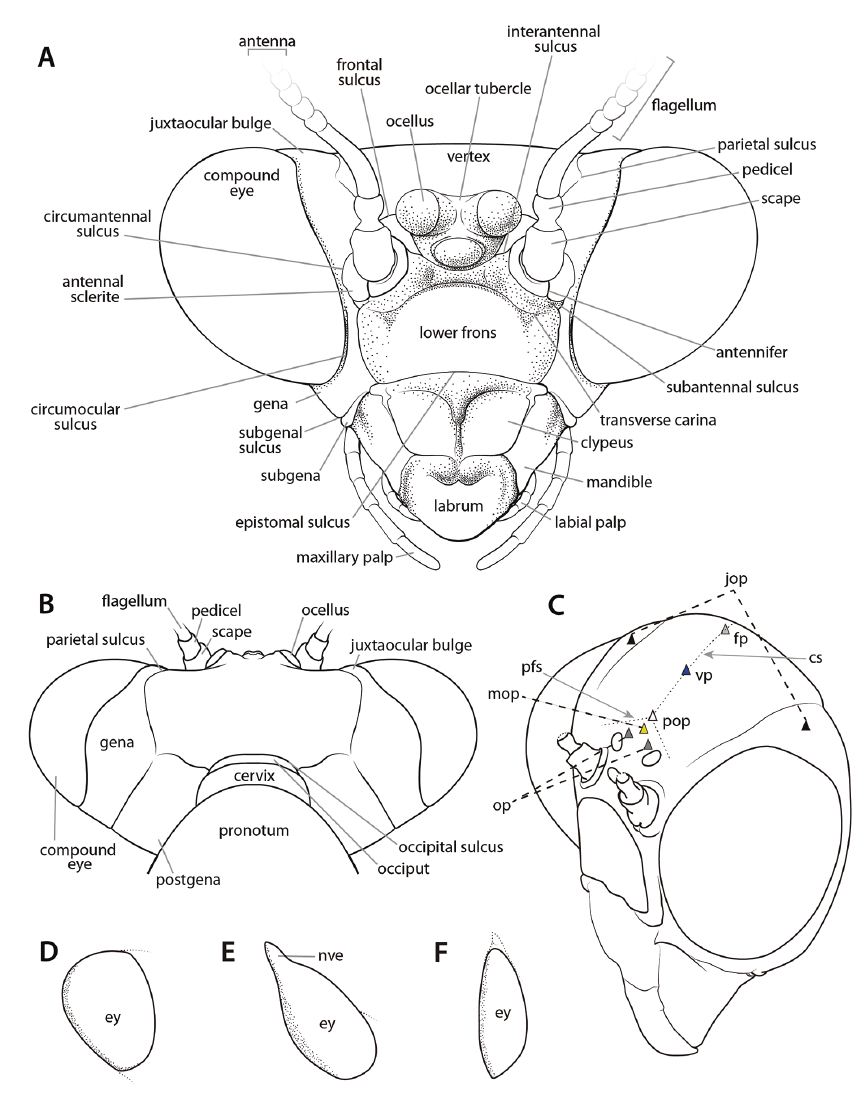
Figure 2. Annotated illustrations of cranial structures. Omomantis Saussure, 1899 ♂ head capsule A an- terior view B dorsal view. Generalized mantis head capsule C oblique anterior view demarcating regions where cranial process can arise; colored triangles indicate approximate locations of cuticular projections: light gray triangle = fastigial process; black triangles = juxtaocular processes; blue triangle = vertical process; white triangle = postocellar process; yellow triangle = medial ocellar process; gray triangle = ocellar process. Various compound eye shapes ( D – F ): D approximately globular in Orthodera Burmeister, 1838 E Het- erochaeta sp. with a non-visual elongation F anteriorly elongate in Schizocephala bicornis Linné, 1758. Illustrations A – B by Josh Maxwell. Abbreviations: cs = coronal sulcus; ey = compound eye; fp = fastigial process; jop = juxtaocular process; mop = medial ocellar process; nve = non-visual elongation; op = ocellar process; pfs = postfrontal sulcus; pop = postocellar process; vp = vertical